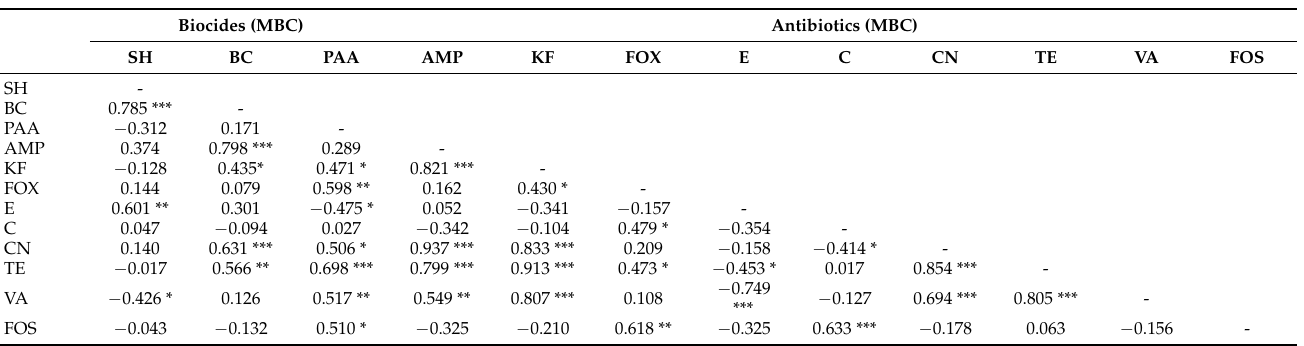
Table 5. Coefficients of correlation between the MBC values of 12 biocides and antibiotics in eight strains of Listeria monocytogenes .